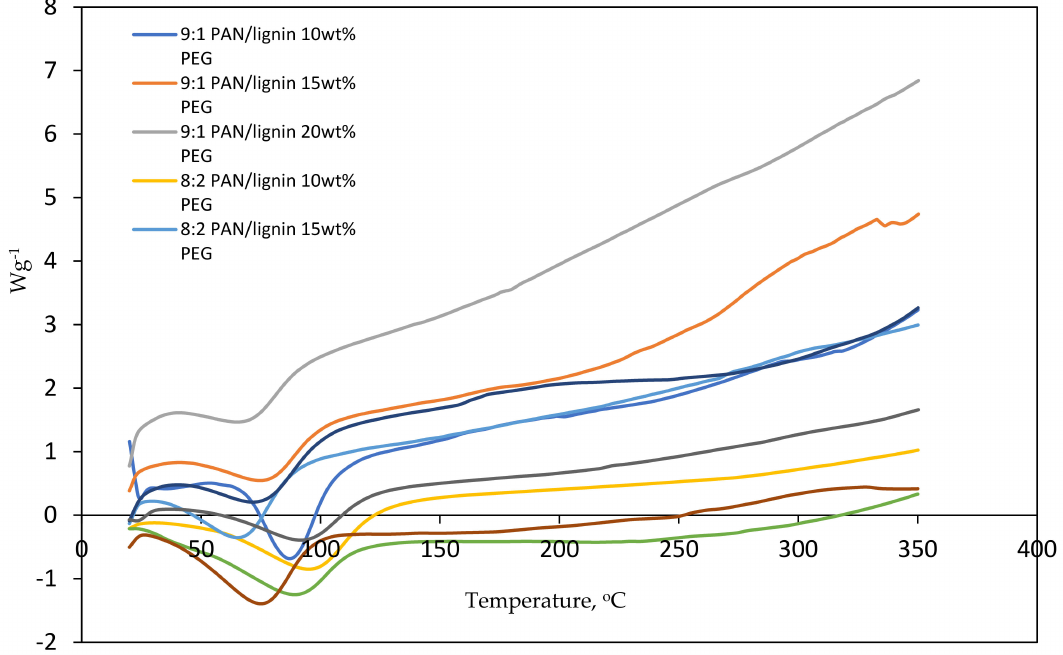
Figure 3. DSC thermogram of electrospun